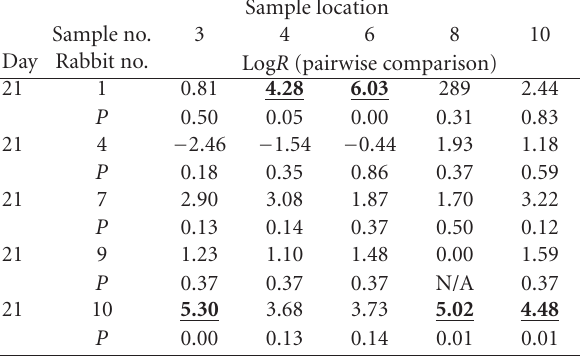
Table 2: Tissue (CFU/g) Log reduction summary tables for day 21. Log reduction values higher than 4 are bold and underlined.